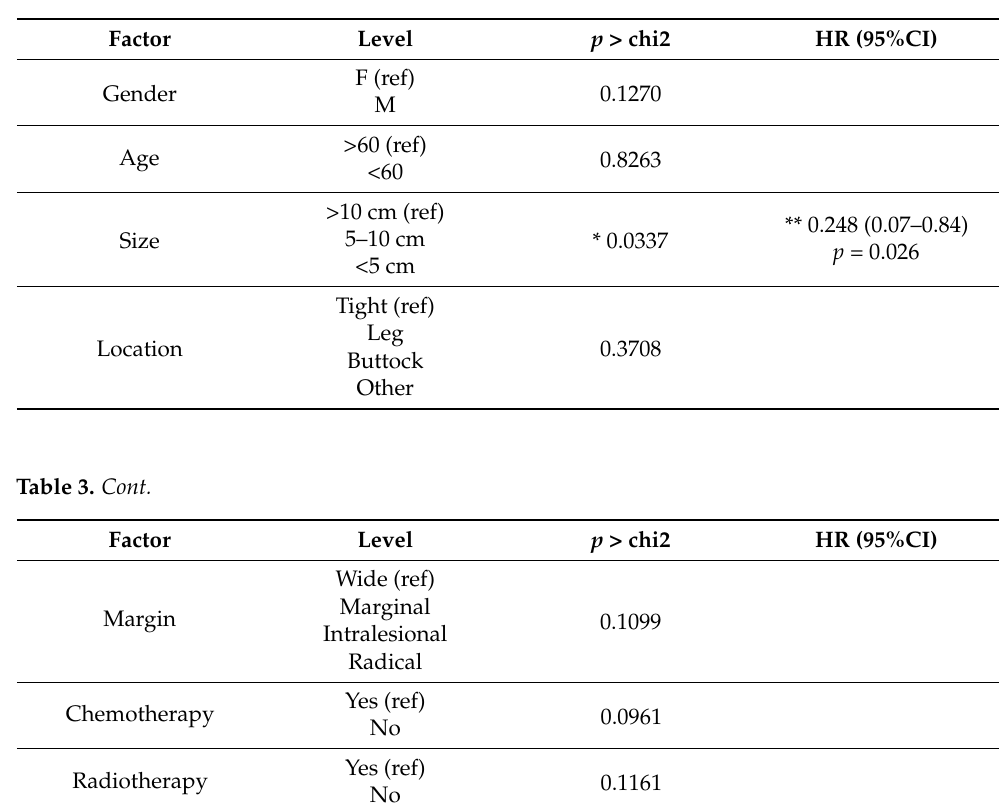
Figure 2. Metastasis-free survival (MFS) Kaplan–Meier curves. ( A ) Overall MFS. ( B ) Kaplan–Meier curve comparing local MFS by size of tumor: size 1 ≥ 10 cm, size 2 = 5–10 cm, size 3 ≤ 5 cm ( p = 0.0337). Table 3. Kaplan–Maier estimates for MFS from patient characteristics. * Log-rank test. ** HRs unadjusted to each other in multivariable analysis. Results unchanged upon adjustment. (Size adjusted for location, RT and margin: HR = 0.24 ( p = 0.029; 95% CI: 0.06–0.866)).